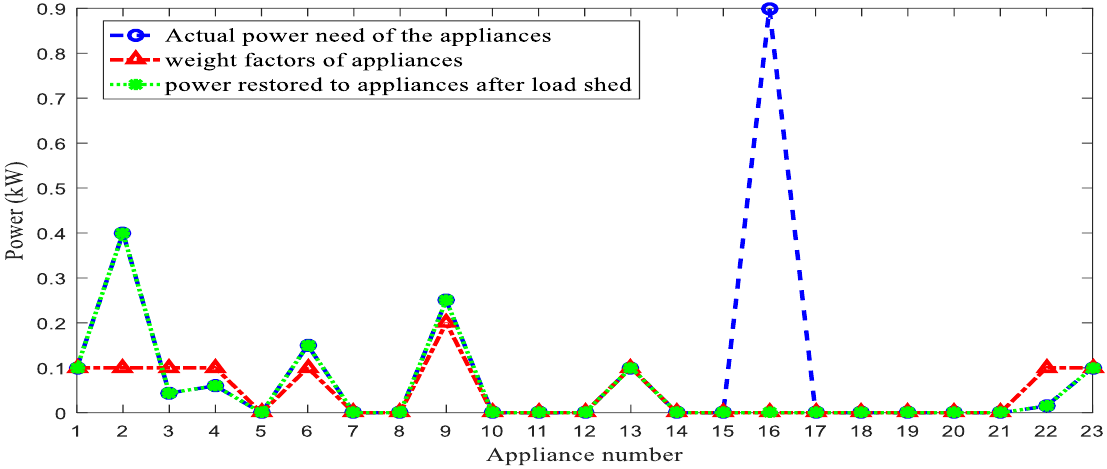
Figure 9. Actual load to meet, weight factors assigned for priority of appliance, and power restored due to EVs for residential user 3.